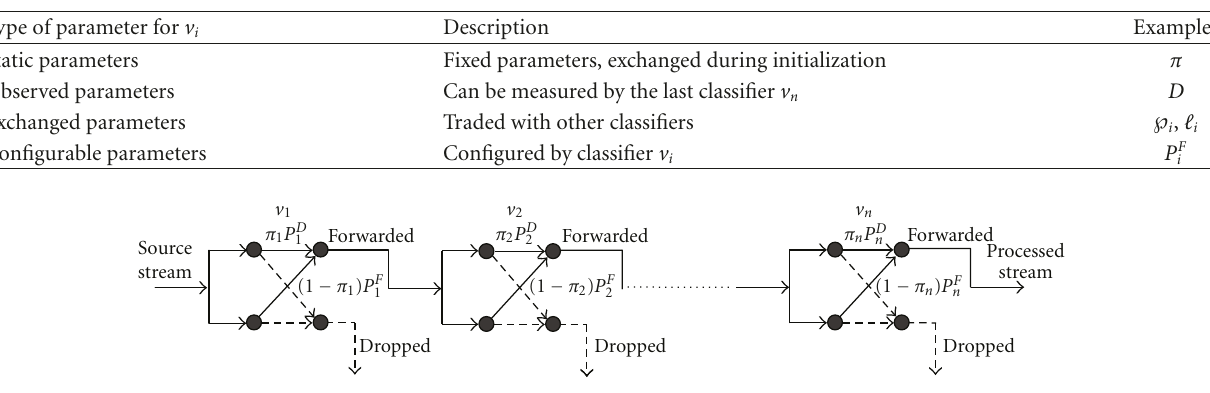
Figure 2: Classifier chain with probabilities labeled on each